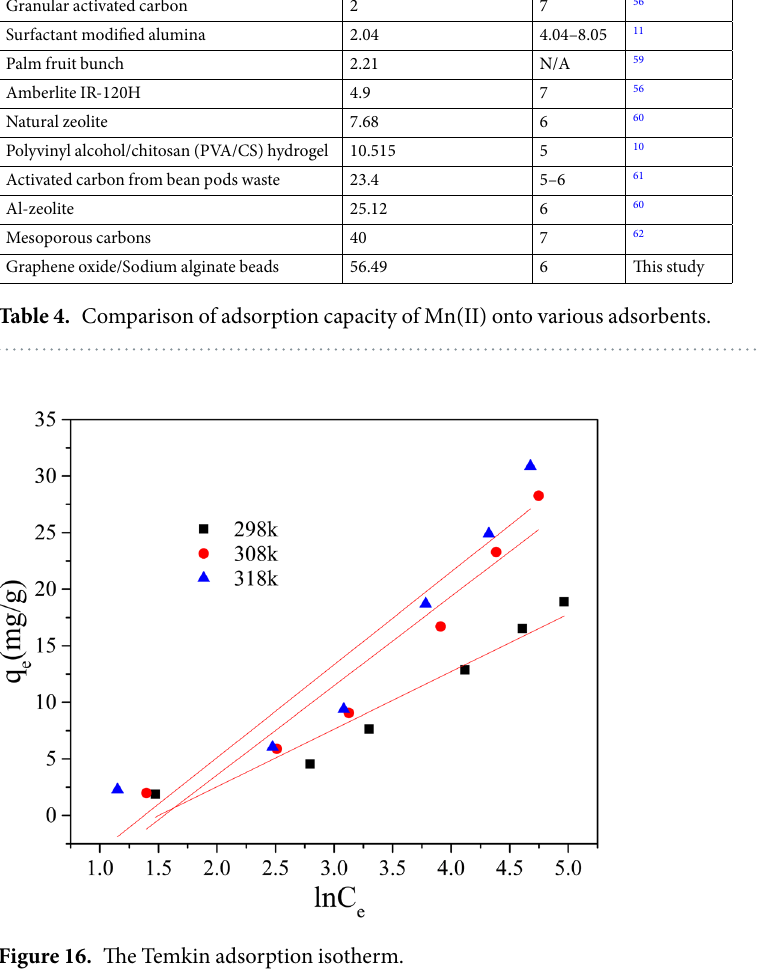
Figure 16. The Temkin adsorption isotherm.